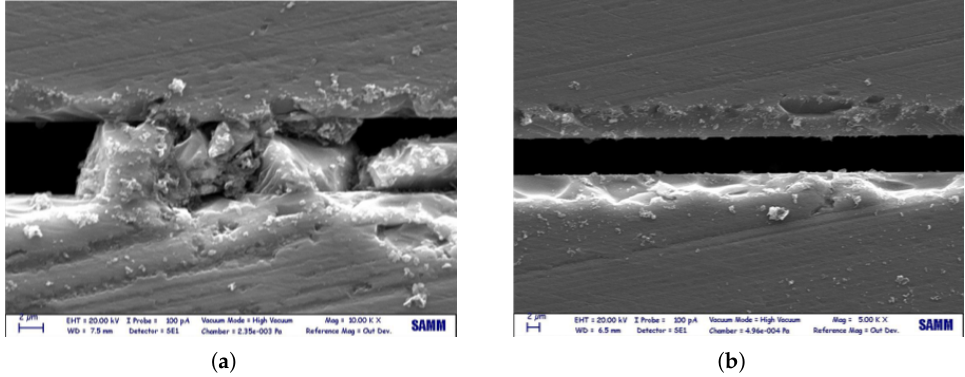
Figure 12. Effect of dicing process on the silicon layers (die cross-section view): ( a ) silicon debris at the interspace of the silicon layers; ( b ) defects introduced by dicing